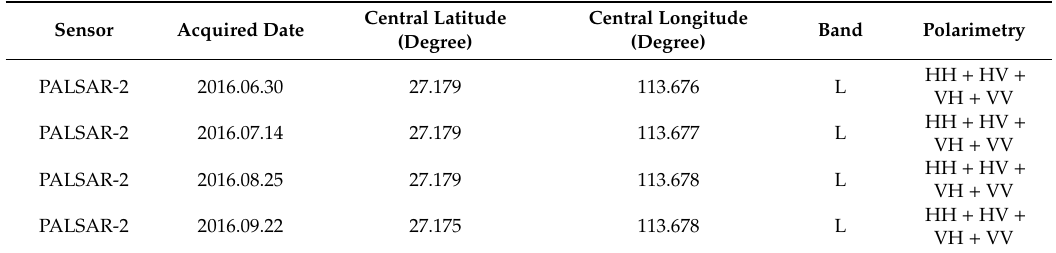
Figure 2. Scatterplot of measured forest parameters and the slope of the study. ( a ) The relationship between DBH and height; and ( b ) the relationship between DBH and forest GSV; ( c ) the slope of the study area derived from ASTER GDEM. Table 1. Information of the polarimetric SAR images.